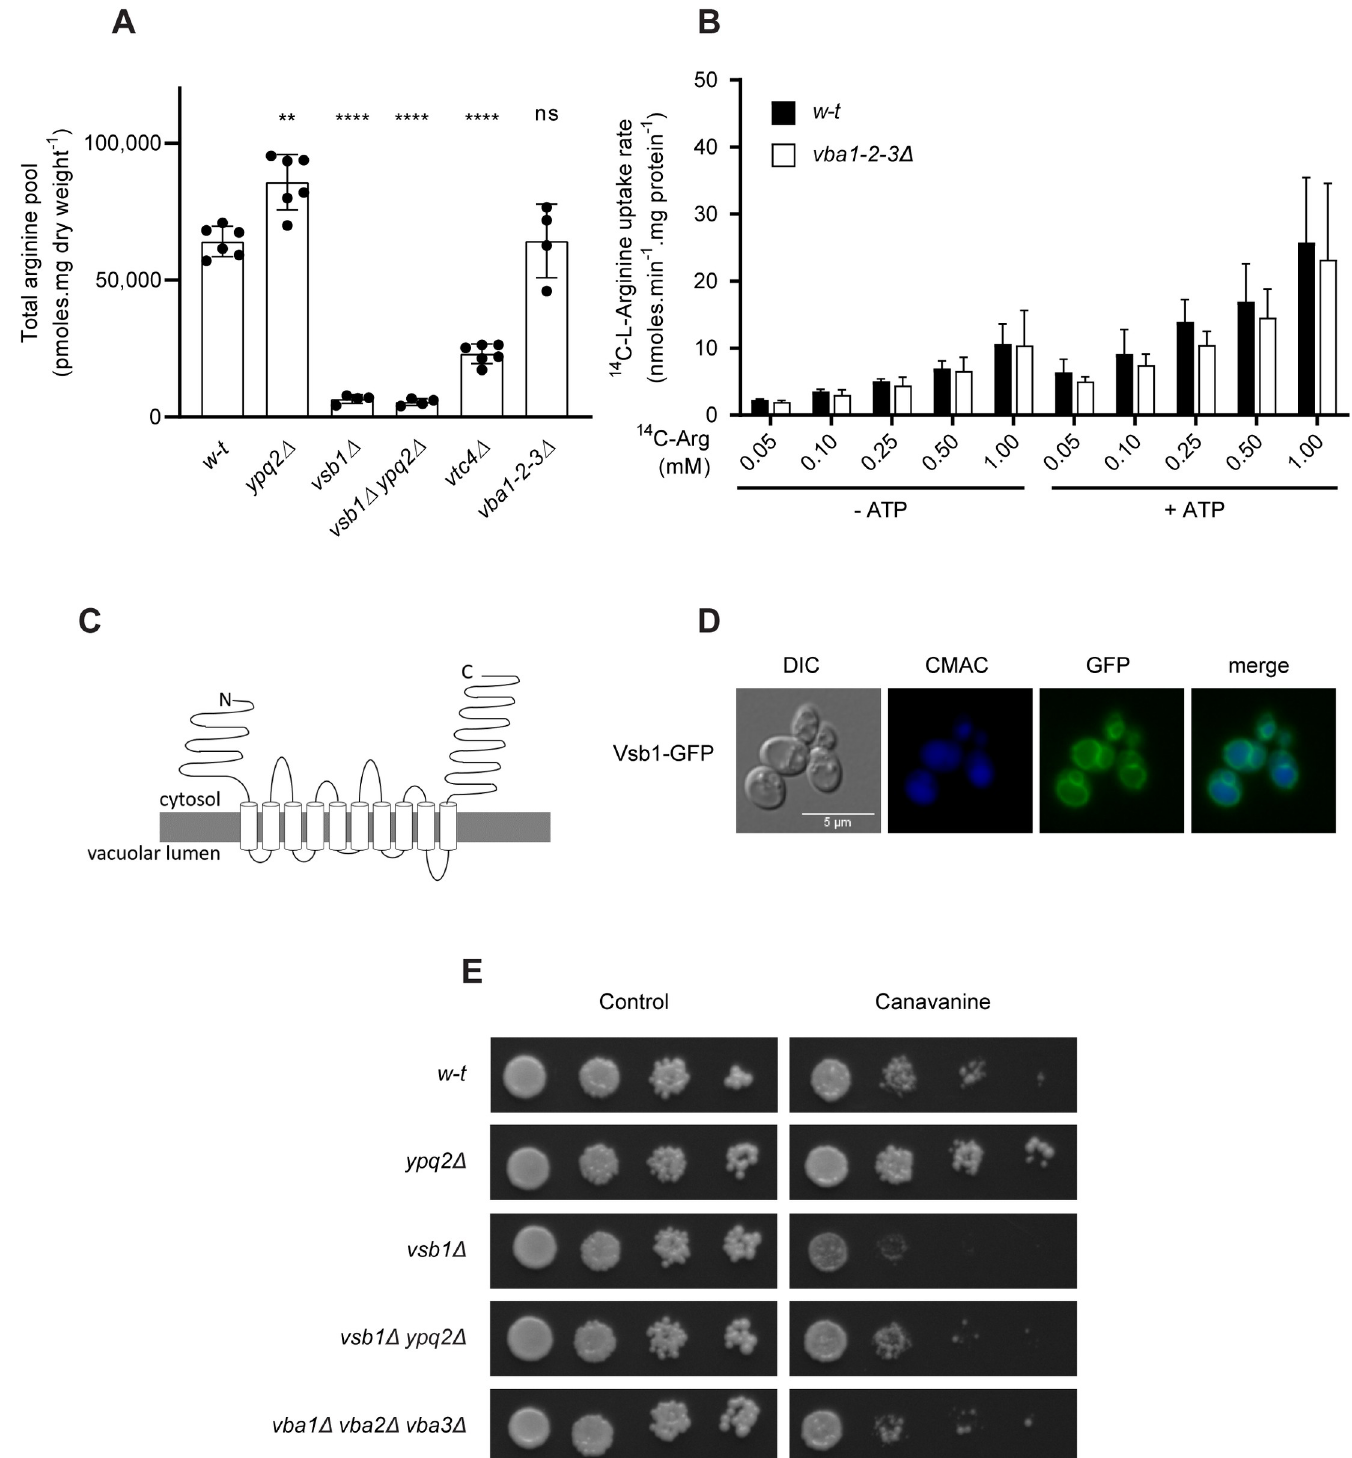
Fig 5. Vsb1/Ygr125w is essential to storage of Arg in the vacuole. (A) The intracellular Arg content was measured in the w-t , ypq2 Δ , vsb1 Δ , ypq2 Δ vsb1 Δ , and vtc4 Δ strains ( �� : p < 0.005 and ���� : p < 0.0001 by the Brown-Forsythe and Welch ANOVA tests) (n = 4–6). (B) Accumulation of 14 C-Arg added at different concentrations (mM) was measured, after a 4-minute incubation, in vacuoles isolated from the w-t and vba1-2-3 Δ strains (n = 3). The vacuoles were incubated for 8 minutes in the absence or presence of ATP (4 mM) before addition of 14 C-Arg. (C) Schematic representation of the Vsb1 protein inserted into the vacuolar membrane. (D) Vsb1